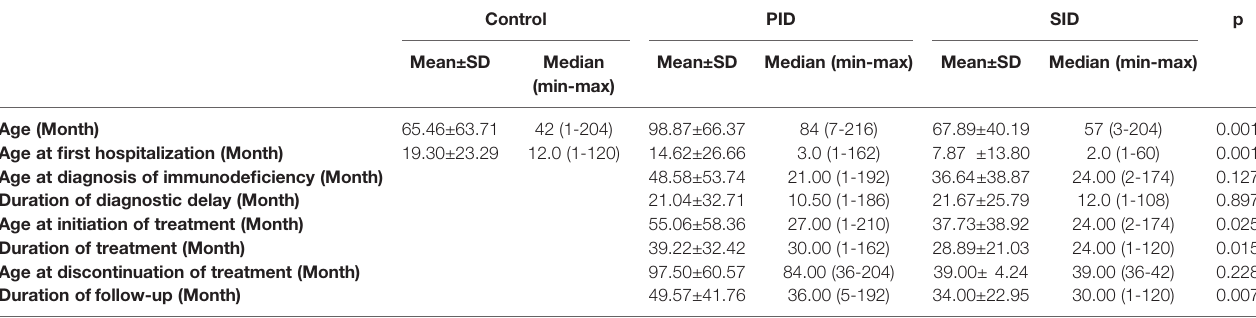
TABLE 1 | The demographic characteristics of the patients with PID and SID, and the control group.